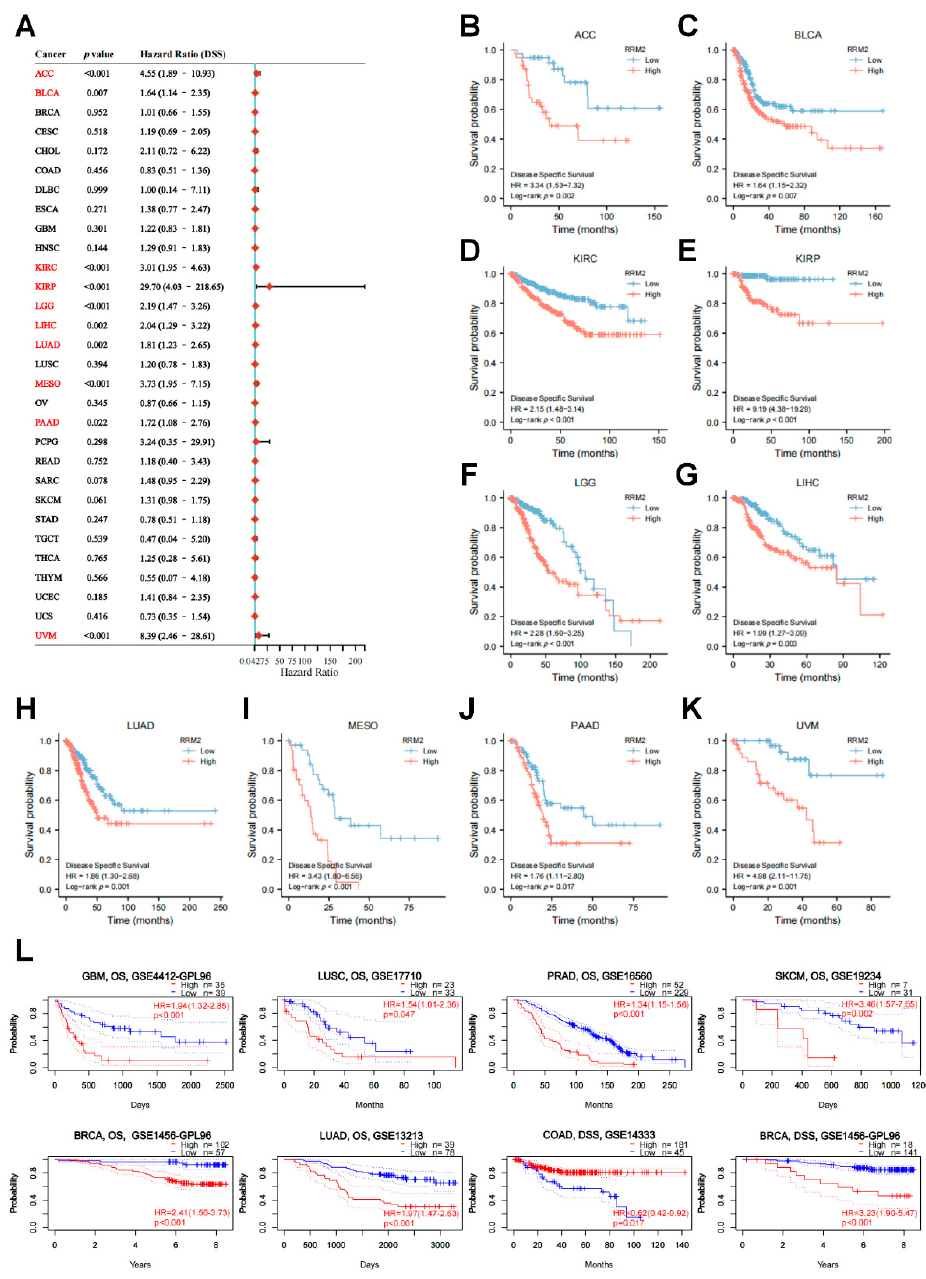
Figure 4. Relationship of RRM2 expression with Disease-Specific Survival (DSS). ( A ) Forest map shows the univariate Cox regression analysis results for RRM2 in TCGA pan-cancer samples (Red color indicated statistical significance). ( B – I ) Kaplan–Meier DSS curves of RRM2 expression in the significantly associated tumors. ( J ) The prognostic value of RRM2 in GEO with PrognoScan database.